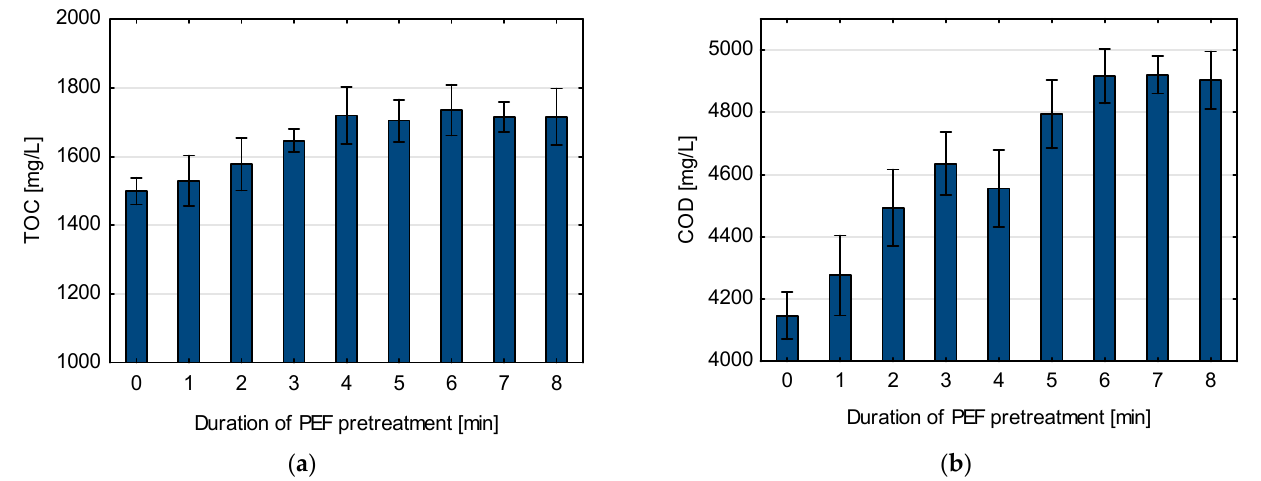
Figure 4. TOC concentration ( a ) and COD value ( b ) in the substrate liquid fraction after PEF disintegration. The effect of using PEF disintegration on the substrate was also determined by ana- lysing the neutral-detergent (NDF), acid-detergent (ADF) and acid-detergent lignin (ADL) fibre fractions. Knowing the content of each fibre fraction allows the determination of the content of cellulose, hemicellulose and lignin in the substrate. The cellulose content of the liquid fraction of the undisintegrated substrate was 49.9 ± 0.6% TS, on average. The hemicellulose content was 12.1 ± 1.2% TS, and the lignin content was 10.3 ± 0.5% TS. The analysis of NDF, ADF and ADL in the PEF pre-treated substrate showed that the best effect was achieved with a retention time of 7 min. The cellulose content decreased to an average of 44.5 ± 1.1% TS. The hemicellulose content decreased to an average of 10.3 ± 0.3% TS and the lignin content decreased to 9.3 ± 1.0% TS (Figure 5). The effect of PEF pre- treatment on the fibre fraction contents was also studied by El Achkar et al. [42]. They used grape pomace as the substrate, and they found no change in the contents of cellulose, hemicellulose or lignin between the raw and disintegrated substrate. Figure 5. Cellulose, hemicellulose and lignin contents of the PEF-disintegrated substrate. The microscopic (SEM) observation of the samples showed clear differences between the undisintegrated sample and the sample disintegrated for 5 min. The destruction of the surface of the control sample and the disintegrated sample was observed (A, B—arrows). However, the extent of the plant tissue damage was more severe in the disintegrated sample (A, B). In addition, fungal hyphae were observed on the surface of the control and the disintegrated sample (C, D—dotted arrows) (Figure 6). The presence of fungal hyphae on the surface of rapeseed straw is natural, and results from the infection of the crop with fungal diseases. Kim et al. [43] investigated the effect of pre-treatment with PEF on ginseng root, and also noted cell membrane damage under electron microscopy. Kovaˇci´c et al. observed structural changes in the lignocellulosic substrate pretreated with electroporation. They showed that the structure of the lignocellulosic substrate was disturbed by pre-treatment. They observed that electroporation led to damage to the cell membrane and the formation of pores [28]. Liu et al. performed an analysis using SEM of the effect of PEF on tea leaf. In their research, they observed unevenly distributed pores on the cell surface that were not present in the untreated PEF sample. In addition to the formation of pores, they also observed highly corrugated, numerous protrusions on the surface of the tea leaf tissues